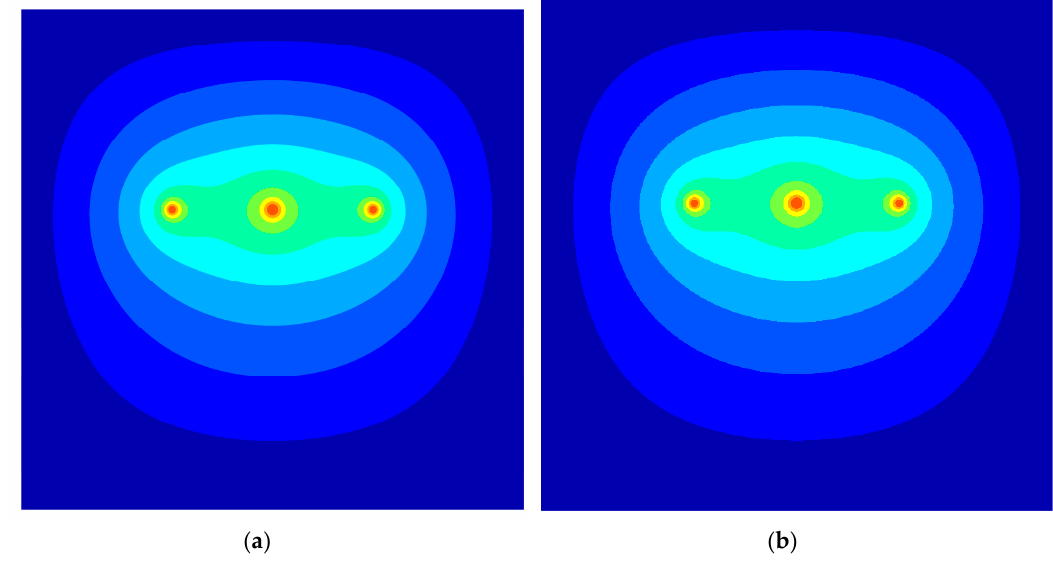
Figure 8. Temperature distribution around the heaters for T air = 40 o C and P = 20 W (a), and T air = 3.7 o C and P = 20 W. T air = 3.7 o C and P = 20